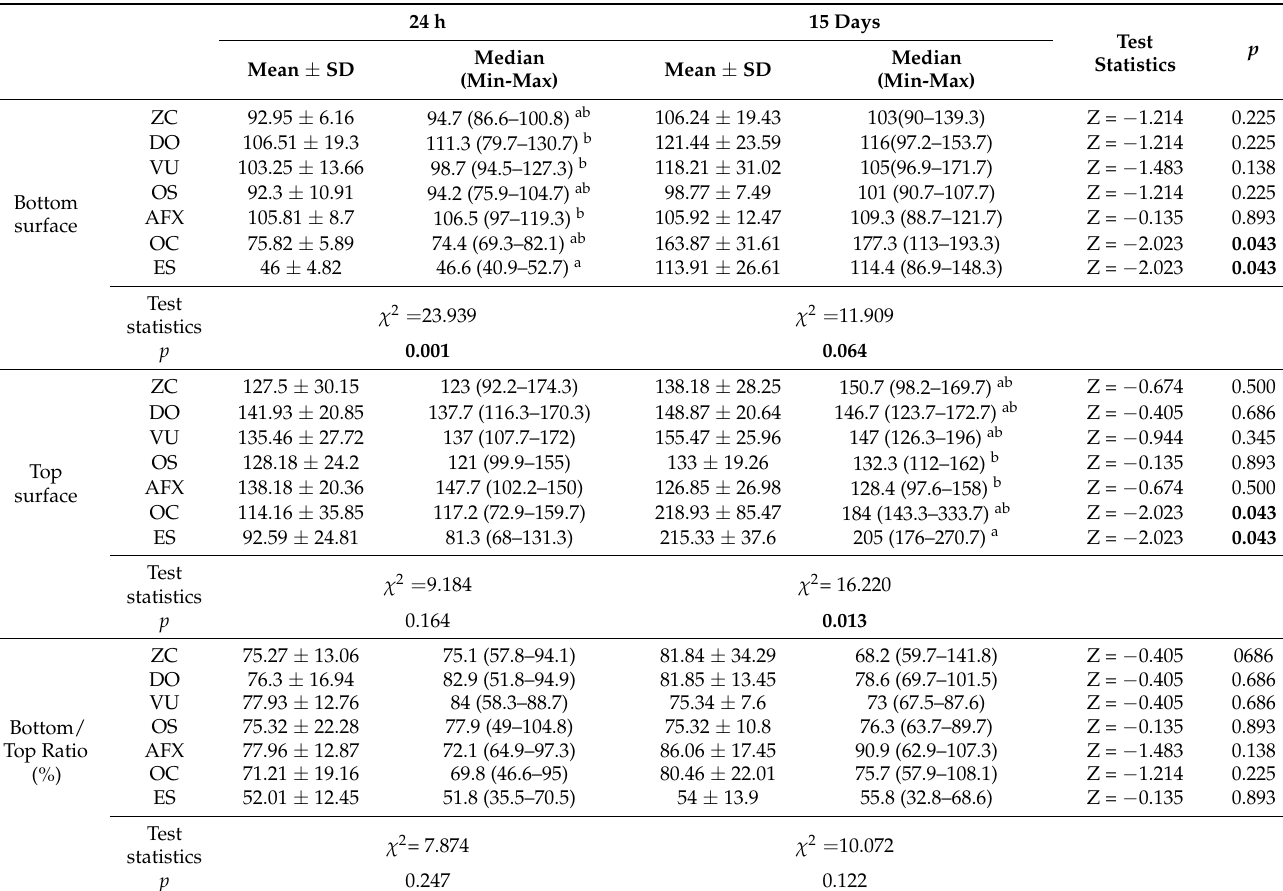
Table 2. Comparison of VHN and DC Values after 24 h and 15 days of the tested materials.